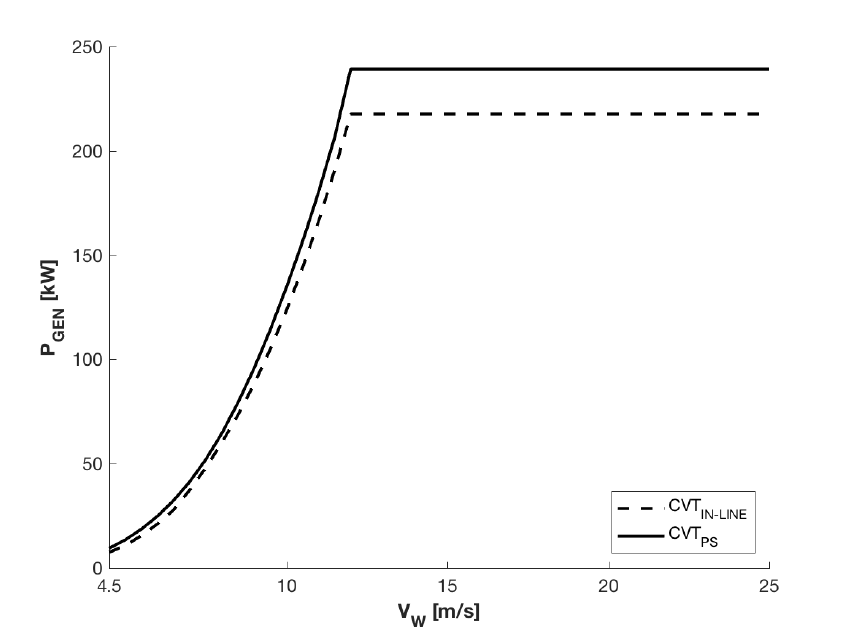
Figure 9. Power supplied to the generator in the two transmission